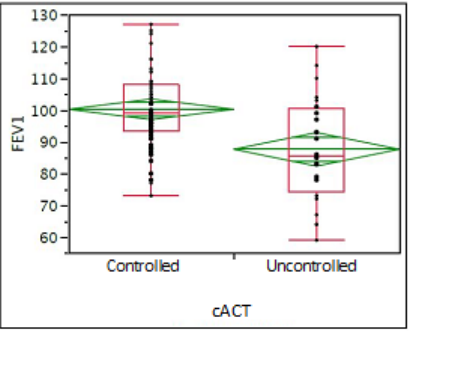
Figure 1. ( A ): associations between FEV 1 (forced expiratory volume in 1 s) and GINA (Global Initiative for Asthma) asthma control grading in the whole sample; ( B ): associations between FEF 25–75 (forced expiratory flow at 25–75% of vital capacity)and GINA asthma control grading in the whole sample; ( C ): associations between CARATkids (CARATkids: Control of Allergic Rhinitis and Asthma Test of pediatric version) grading and FEV 1 in children; ( D ): associations between CARATkids grading and FEF 25-75 in children. Data are expressed as medians and interquartile ranges. An ANOVA test was used. Circles concern the All-pairs Tukey-Kramer test.